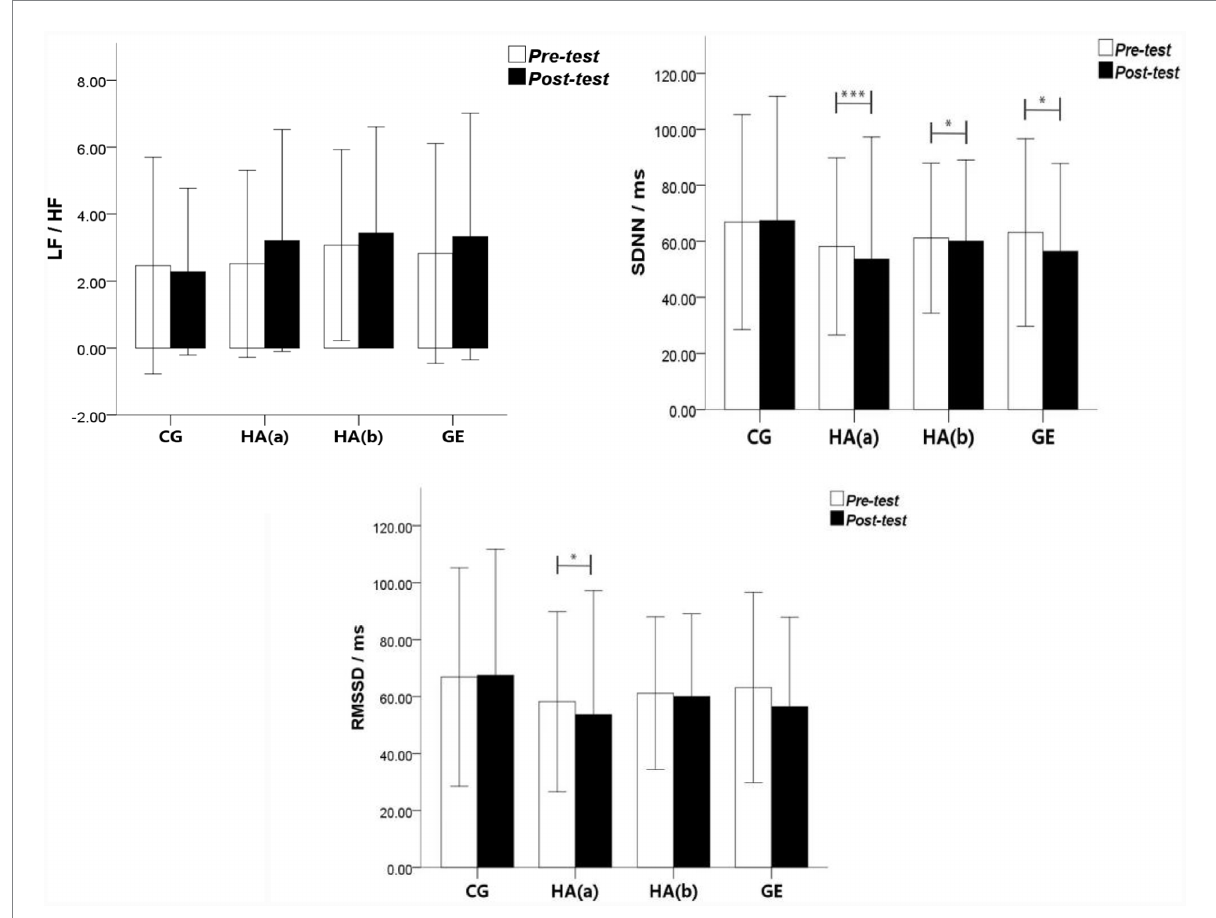
FIGURE 7 Pre-test and post-test change trends of HRV indexes LF/HF, SDNN and